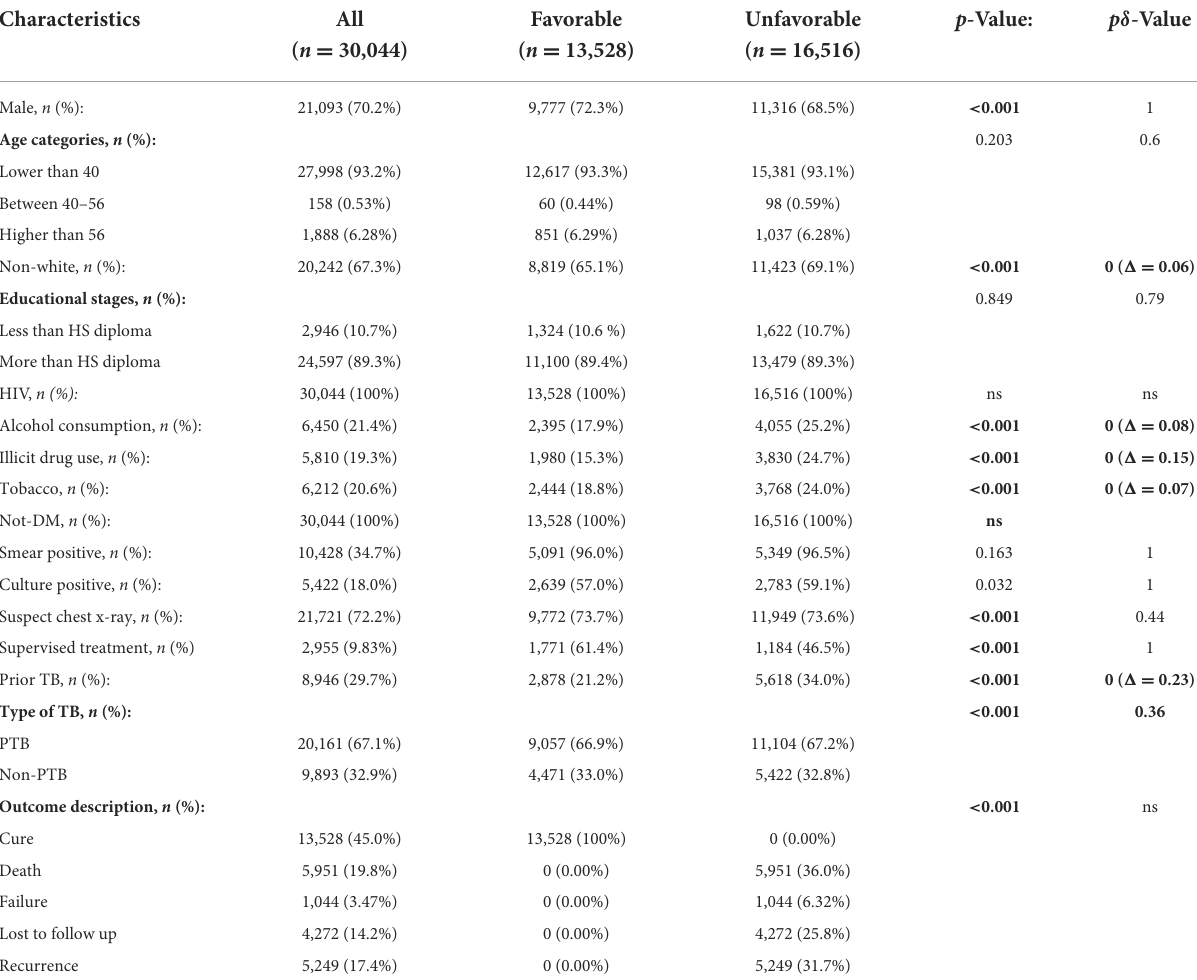
TABLE 4 Characterization of treatment outcomes in TB-HIV without DM.